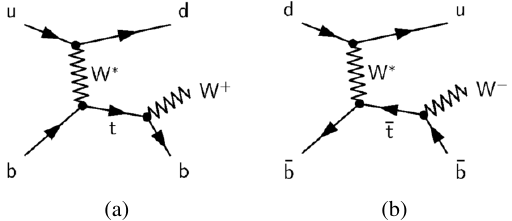
Figure 1 . Representative leading-order Feynman diagrams of (a) single-top-quark production and (b) single- top-antiquark production via the t -channel exchange of a virtual W boson ( W (cid:3) ), including the decay of the top quark and top antiquark,